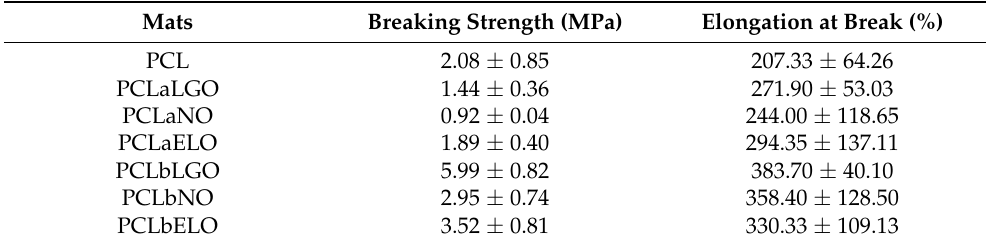
Table 5. Unloaded and EOs-loaded PCL mats mechanical examinations. Data are reported as mean ± S.D. ( n = 3). Mats Breaking Strength (MPa) Elongation at Break (%)